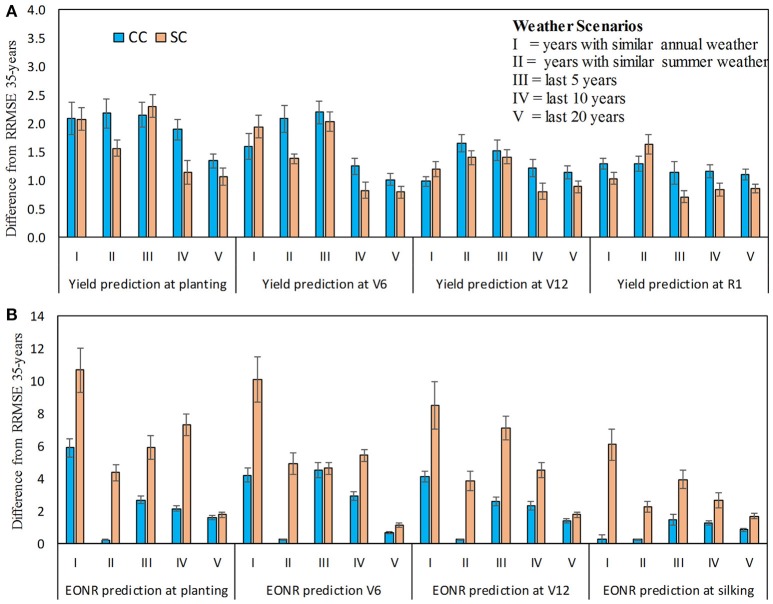
Differences in relative root mean square error (RRMSE) between weather scenarios (I-V) and standard approach (use of 35-years of weather data) for predicted corn yield (A) and economic optimum N rate (B) at four forecasted times: planting, V6 (6th leaf), V12 (12th leaf), and R1 (silking) stage. The positive values indicate that using the 35-years of weather history is better than use of other weather scenarios (I–V). Continuous corn (CC) and soybean-corn (SC). Vertical bars represents the standard deviation.